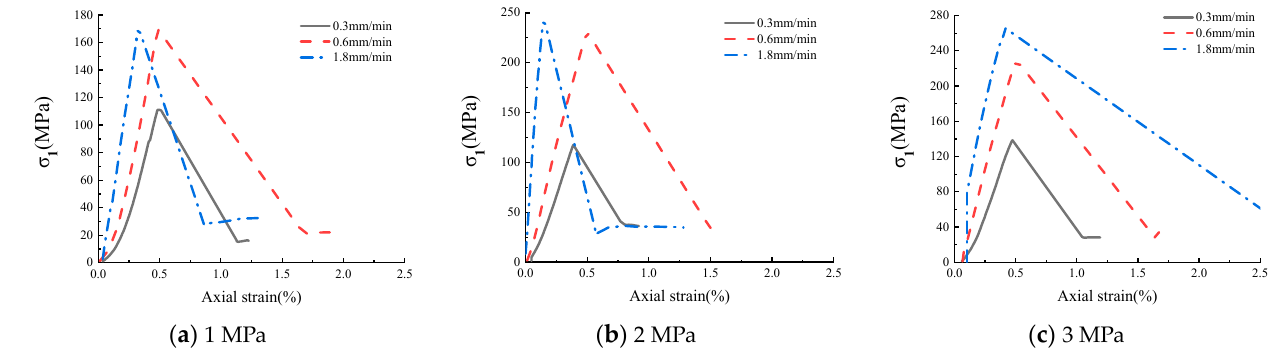
Figure 5. Stress–strain curves of specimens under different confining pressures. Table 1. Triaxial compression test results.